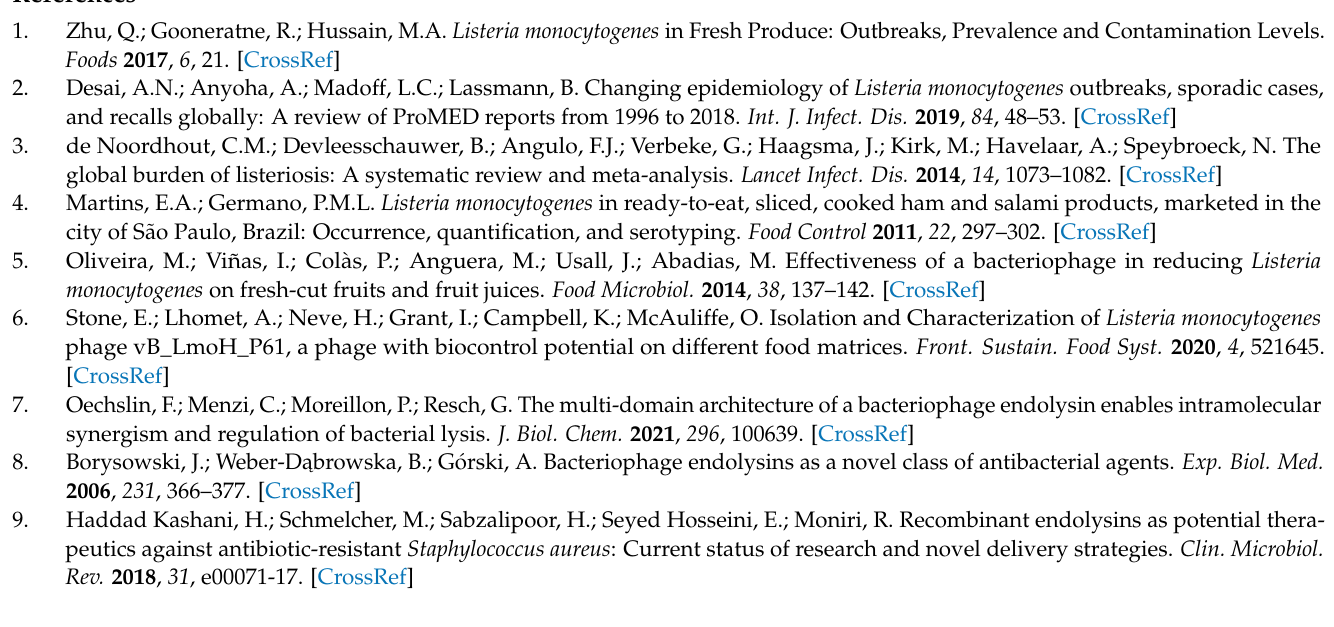
periment, Figure S2: Flow chart depicting the experimental design of the assays, Table S1: Gene sequences of lysin293 and the amidase domain,